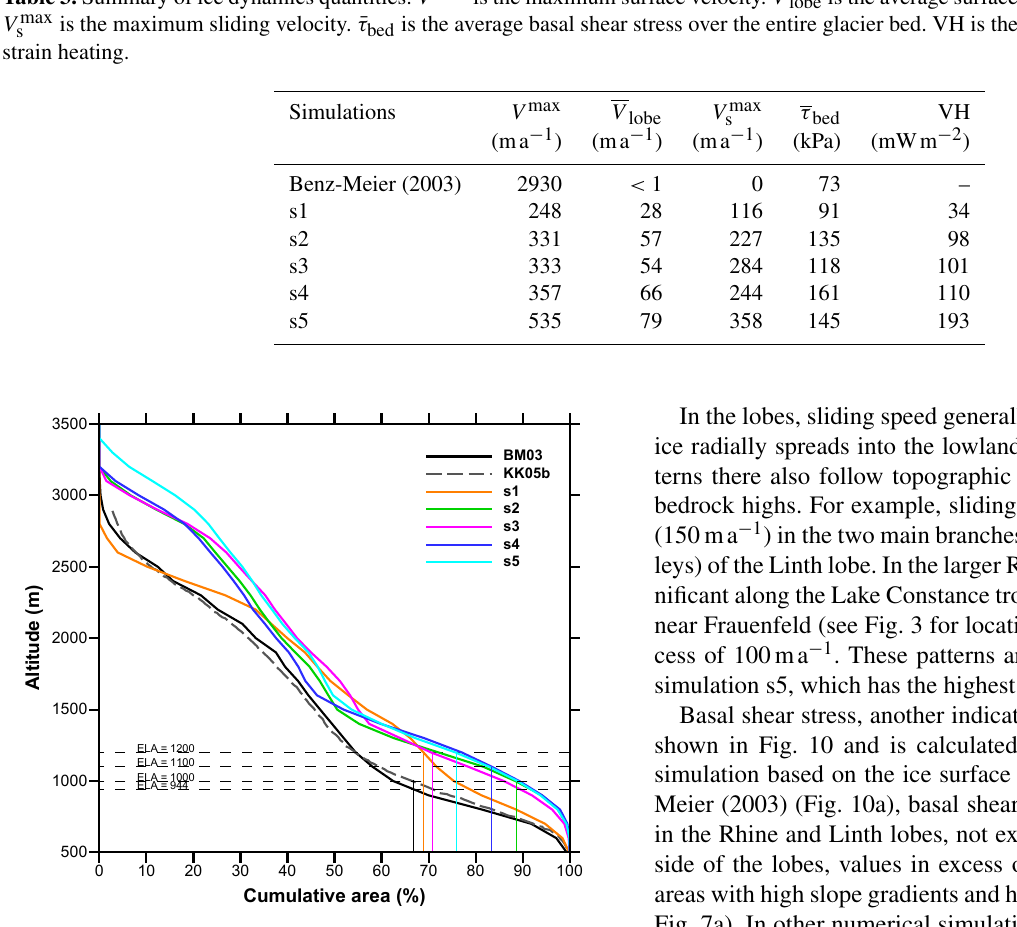
Figure 6. Glacier hypsometric curves for geomorphic and numer- ical reconstructions of the Rhine glacier system. Vertical colored lines show the value of the AAR on the x axis for each reconstruc-